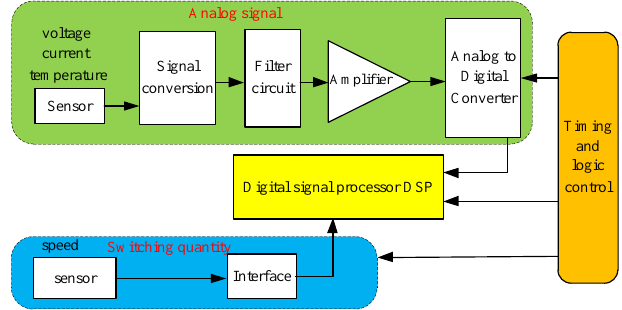
Figure 4. Sensor signal acquisition and processing.